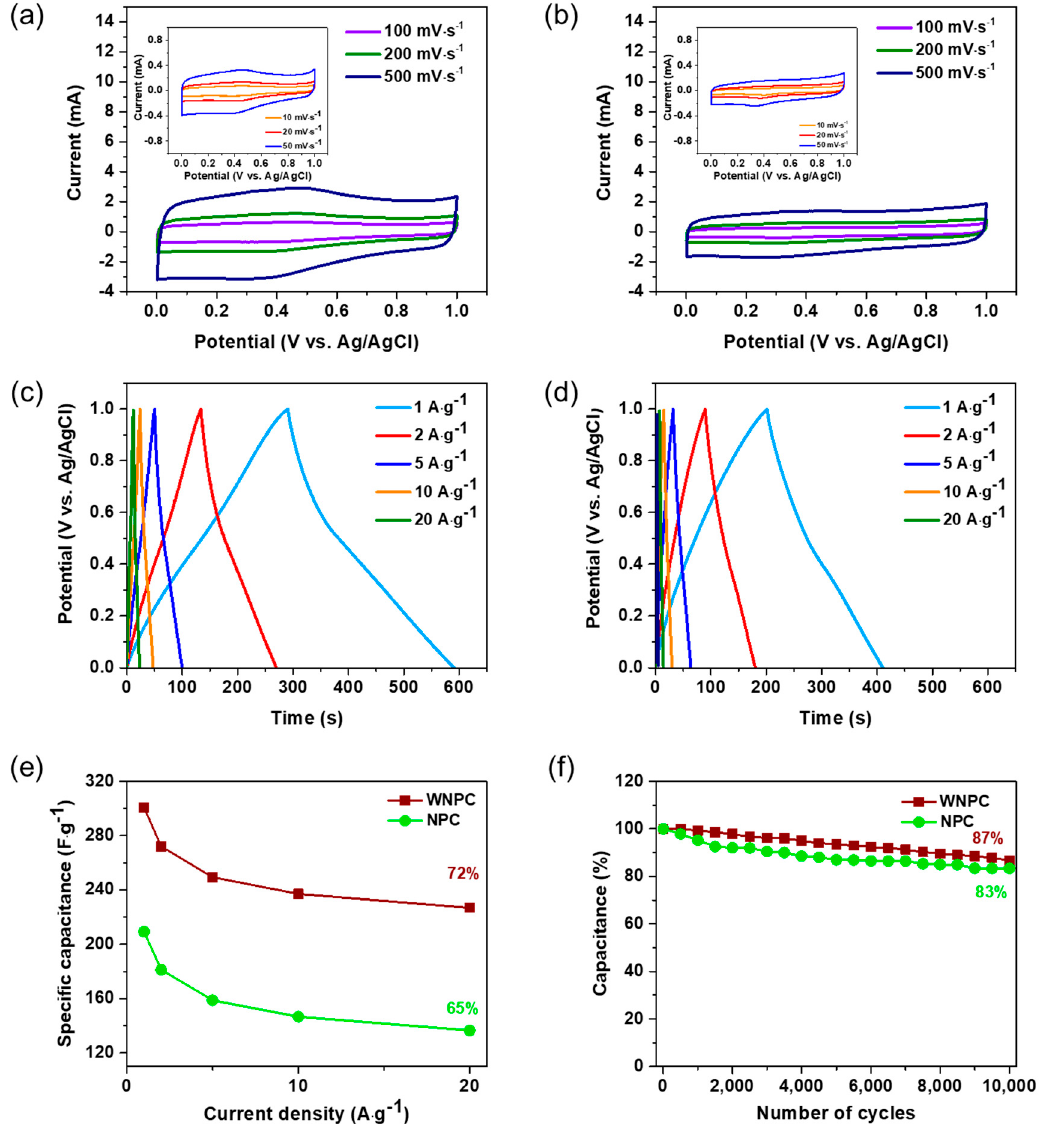
Figure 5. Cyclic voltammograms (CV) curves of ( a ) WNPC and ( b ) NPC with different scan rates; galvanostatic charge–discharge (GCD) curves of ( c ) WNPC and ( d ) NPC at different current densities; ( e ) Variation of specific capacitance against the current density of WNPC and NPC; ( f ) Cycling performance of WNPC and NPC electrode at a current density of 4 A·g − 1 .